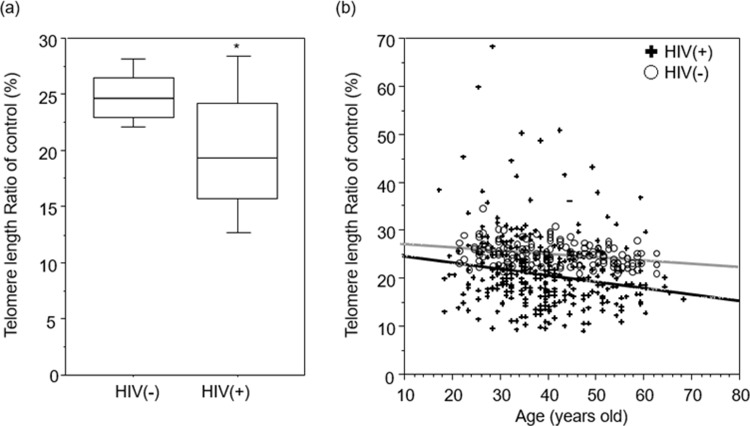
Comparison of TLs in HIV+ and HIV- individuals.LTLs were measured using real-time quantitative PCR and expressed as a ratio to a housekeeping gene (T/S ratio). Data shown are normalized to an internal control. (a) Box plot showing differences in LTL between HIV+ and HIV- individuals. * indicates p<0.0001 relative to HIV- individuals by Mann-Whitney U-test. (b) Absolute LTL by age. Solid lines represent regression lines, black line represent HIV+ individuals (r = -0.134), and gray line represents HIV- individuals (r = -0.069).